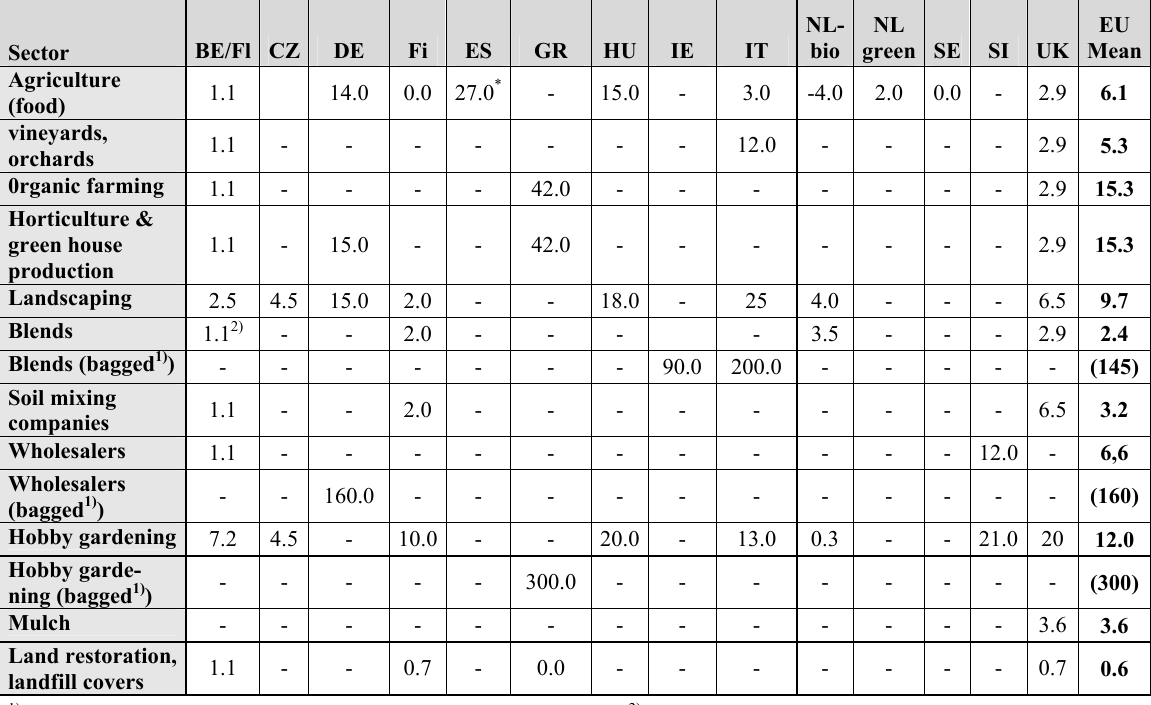
Table 36: Investigated national average market prices in the different sectors (€/t per t f.m.)